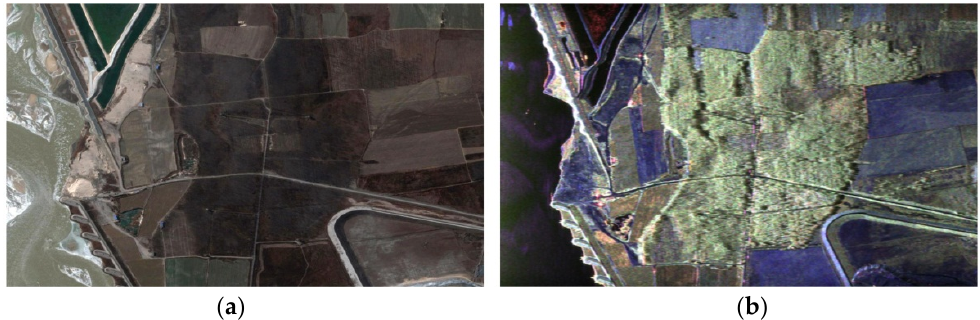
Figure 6. Airborne PolInSAR experimental data. ( a ) Google Earth optical map of forest area. ( b ) Pauli base PolSAR decomposition map.